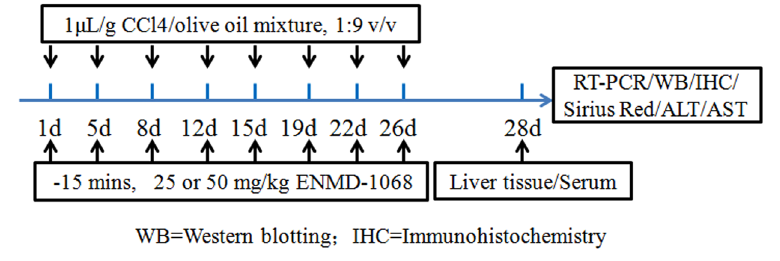
Figure 1. Time schedule for CCl 4 and ENMD-1068